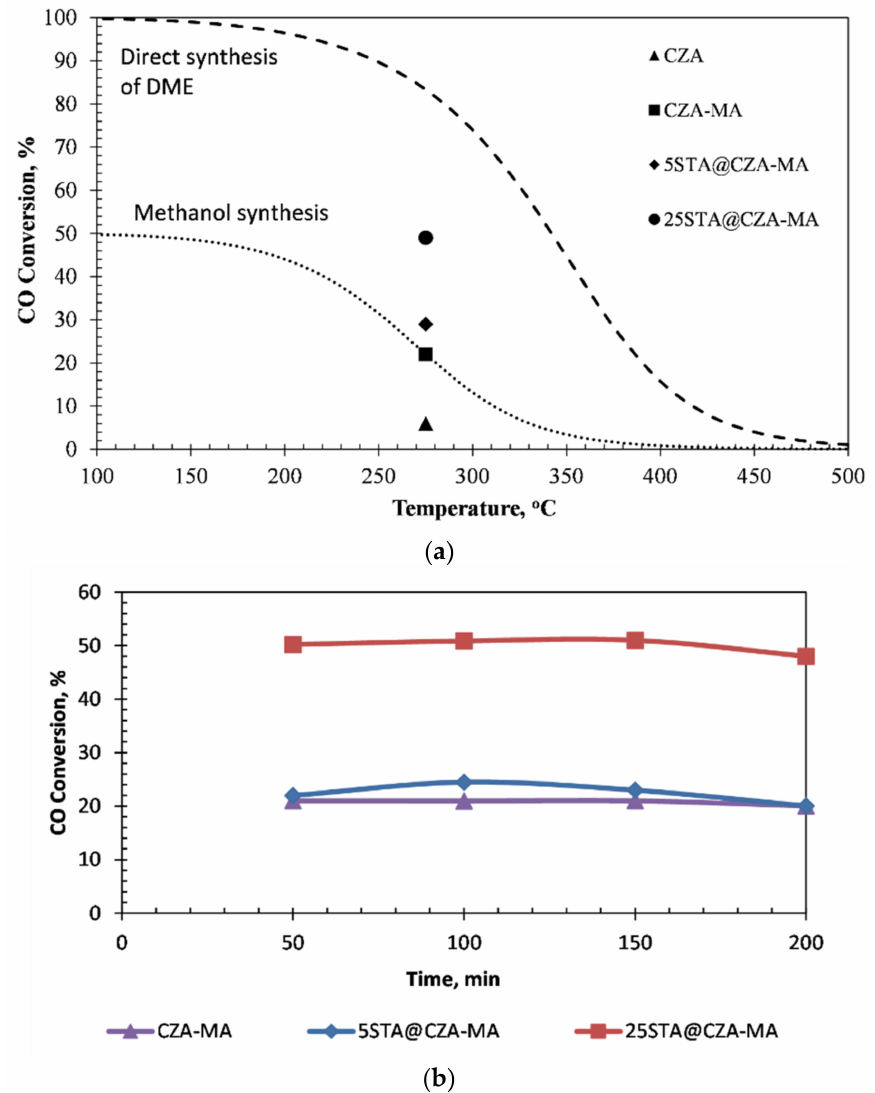
Figure 7. ( a ) Comparison of activity test results with equilibrium conversion values predicted from thermodynamic analysis, ( b ) CO conversion values with the STA incorporated core-shell catalysts (feed stream = CO/H 2 :1/1; P = 50 bar) (T = 275 ◦ C; P = 50 bar; CO/H 2 :1/1 as feed stream; space-time of 0.72